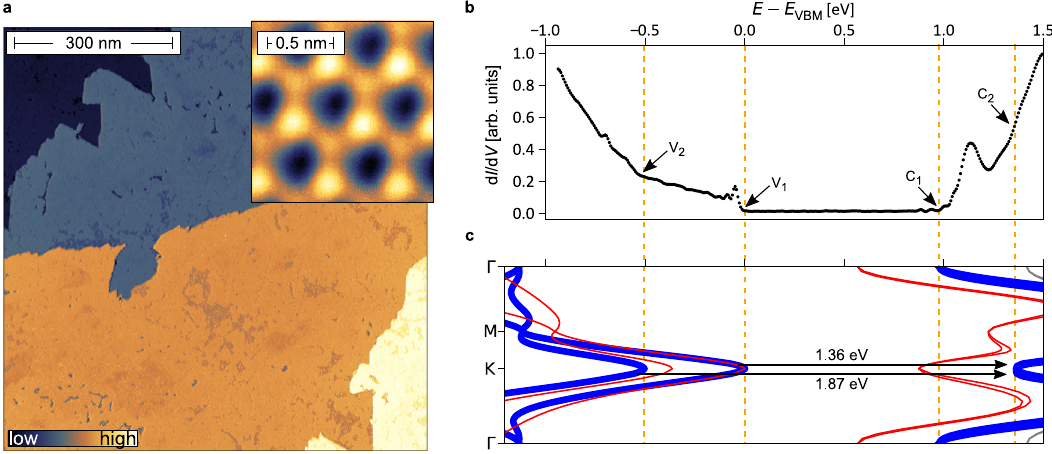
Fig. 1 | Single-particle electronic properties of Bi/SiC. a Constant current STM of the bismuthene fi lm, but originates from a local defect state inthe SiC substrate (seeSectionIIoftheSupplementaryInformation). c GW bandstructurecalculation image of bismuthene on SiC(0001). The topographic map displays the high cov- (blue curves) for bismuthene. The direct optical transitions at the K-point are erage(~87%)ofthe epitaxiallygrownBimonolayerand the terracestructure of the indicated by arrows. Also shown is the DFT band structure obtained with the HSE underlying SiC substrate. ( T =4.2K and V set =2.6V, I set =50pA.) Inset: A high- hybrid functional (red curves) 20 , illustrating the propensity of DFT to under- resolution measurement reveals the bismuthene honeycomb lattice. ( T =4.2K and V − 0.4V, I I /d V ) spectrum, estimate the band gaps. Characteristic points in the spectrum that correspond to set = set =200pA.) b Differentialtunneling conductivity (d the valence band onsets ( V 1 , V 2 ) and the conduction band onsets ( C 1 , C 2 ) are locally measured in the center of the bismuthene fi lm ( T =4.2K and V set = − 0.4V, V ≈ 1.1eV is not anintrinsicfeature I set =200pA, mod =10mV). Note thatthe peakat